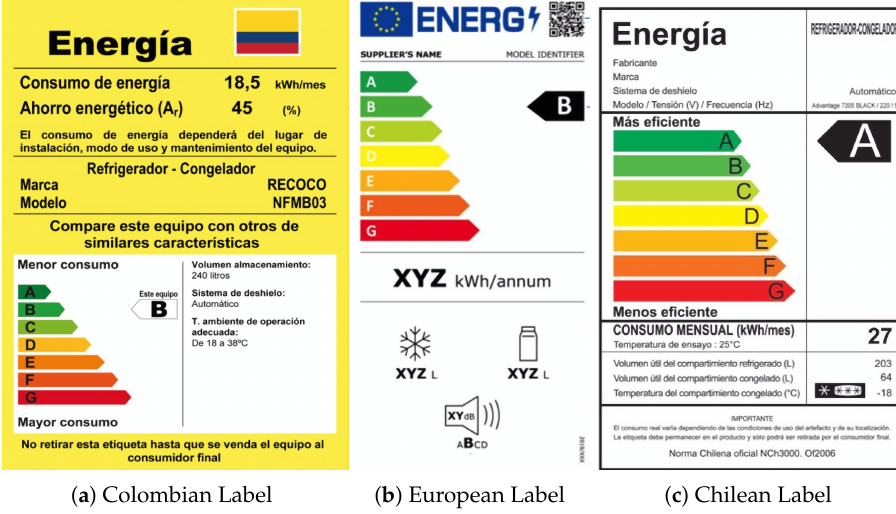
Figure 4. Energy Labels for Domestic Refrigeration in Colombia, EU and Chile.